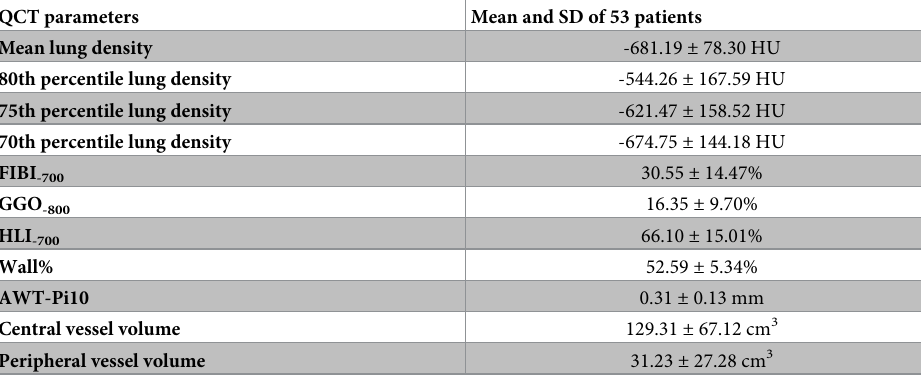
Table 3. QCT parameters of 53 COVID-19 patients in the soft kernel images